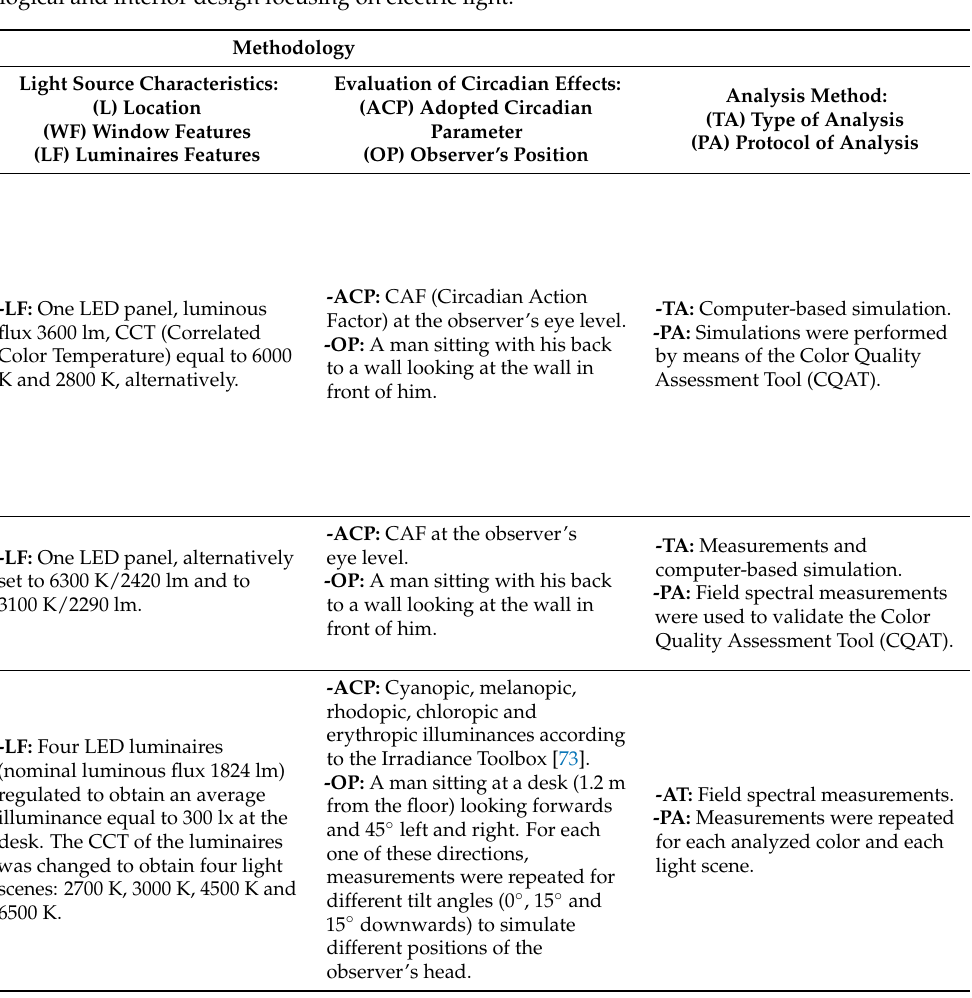
Table 3. Papers analyzing factors related to technological and interior design focusing on electric